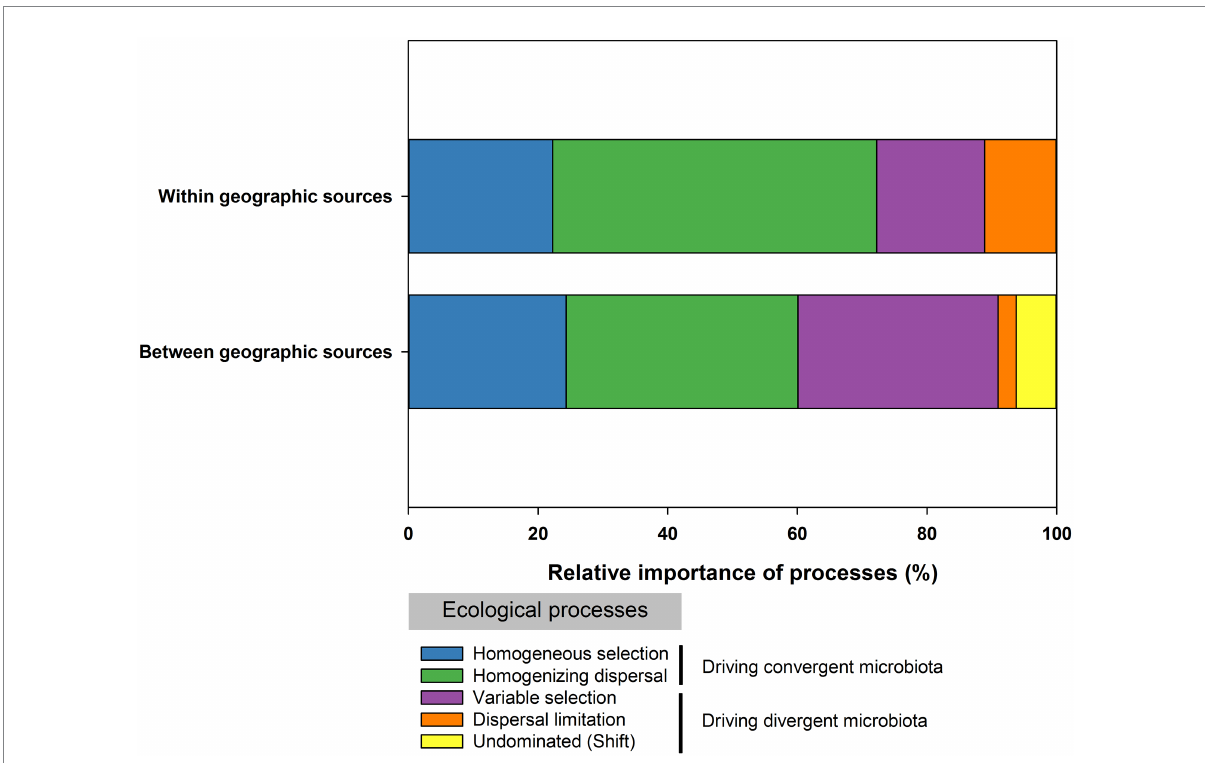
FIGURE 9 The relative importance of ecological processes in governing the gut bacterial communities of C. medinalis within or between geographical